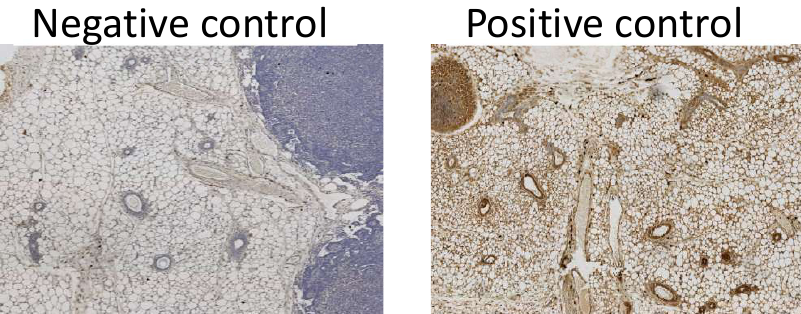
Figure A2. Image showing examples of the negative and positive controls used in this study. The negative control was an antibody free control to determine any background staining caused by the kit used. The positive control was performed on tissue known to express the protein in question. These tests were performed on the same tissue types for each run performed, with this tissue being full adult, >16 weeks of age, wild type mammary